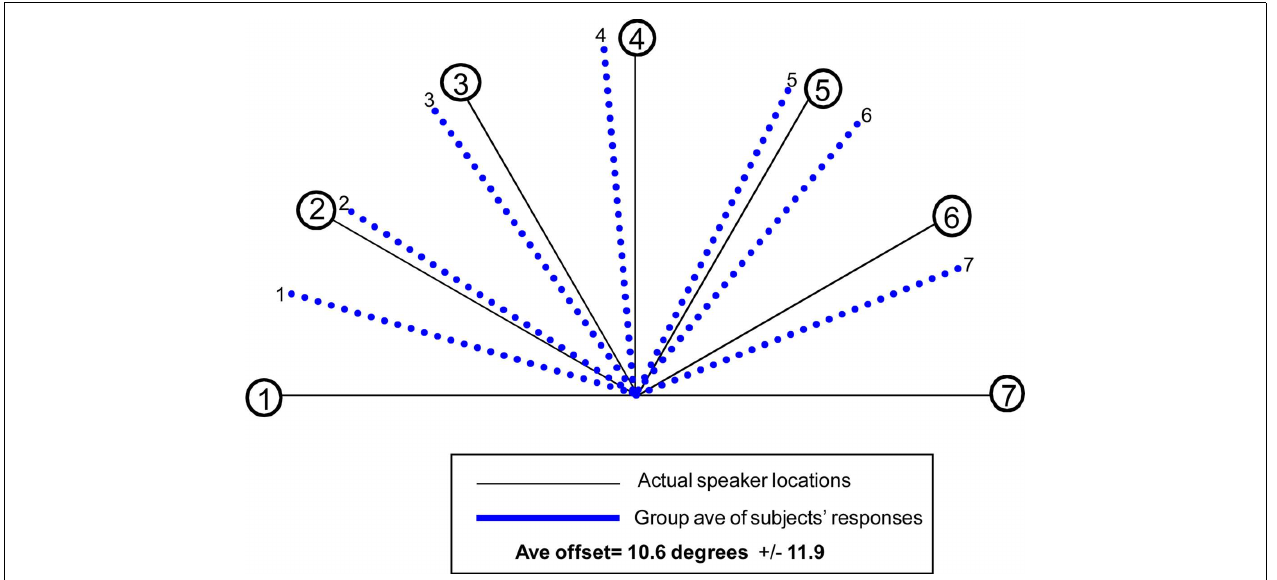
FIGURE 4 | Behavioral results for the “ WHERE” condition. Blue lines identify the average of responses across 11 participants (one had to be excluded due to a technical problem capturing responses) for each of the seven sound source locations. Average offset of responses for all seven locations collapsed was 10.6˚ ±